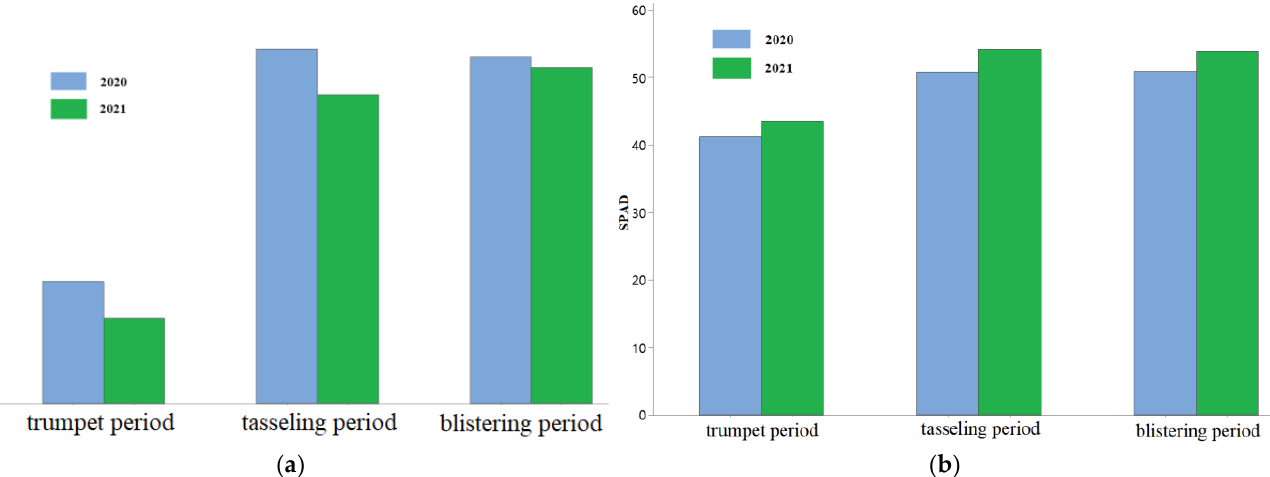
( b ) Figure 7. Scatter plot of extraction results and measured values of each model prescription map. ( a ) LAI model; ( b ) SPAD model. Figure 7b showed that the measured value and the extracted value of the prescription map were evenly distributed near the fitting line. However, the scattered points were rel- atively discrete. The fitting line of the RF model was the closest to the 1:1 line, followed by the MLR model, and the PLSR model had the largest deviation. It was shown that each model could effectively predict the SPAD change in summer maize, and the RF model had the best prediction effect. Due to the influence of the linear model itself, the fitting lines of the MLR and PLSR models in the later stage of growth deviate from the 1:1 line